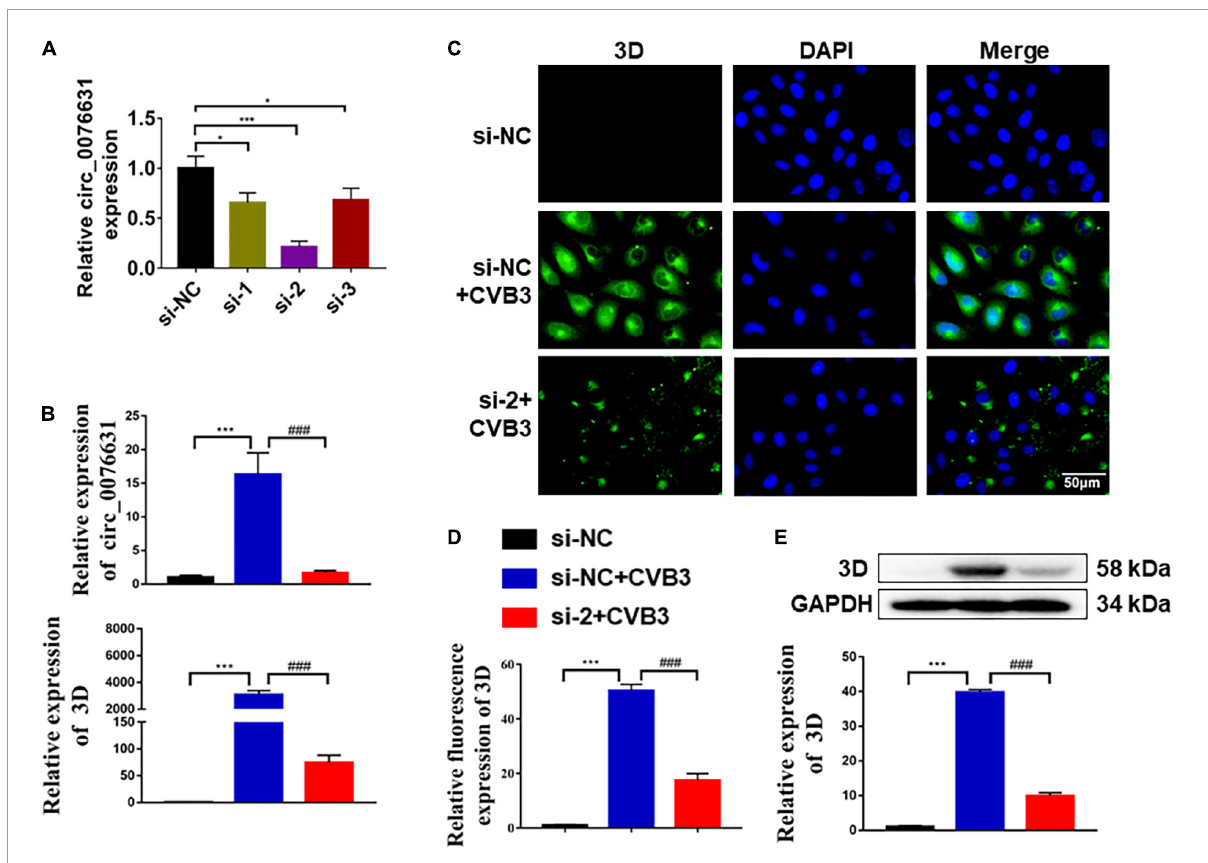
FIGURE2 Circ_0076631 knockdown suppresses CVB3 replication. (A) HeLa cells were transfected with circ_0076631 siRNA (si-1, si-2, si-3) and cultured for 24 h. The abundance level of circ_0076631 was assayed by RT-qPCR. n = 3. * P < 0.05, *** P < 0.001. (B–E) HeLa cells were transfected separately with si-NC and si-circ-0076631 for 24 h. After infection with CVB3 (MOI = 10) for 6 h. (B) The relative abundance level of circ_0076631 and CVB3 3D-coding RNA detected by RT-qPCR. (C,D) Immunofluorescence staining was performed to detect the level of CVB3 3D protein. (E) The relative level of CVB3 3D protein was detected by western blotting. n = 3. ** P < 0.01, *** P < 0.001 compared with the si-NC. # P < 0.05, ## P < 0.01, ### P < 0.001 compared with the si-NC + CVB3